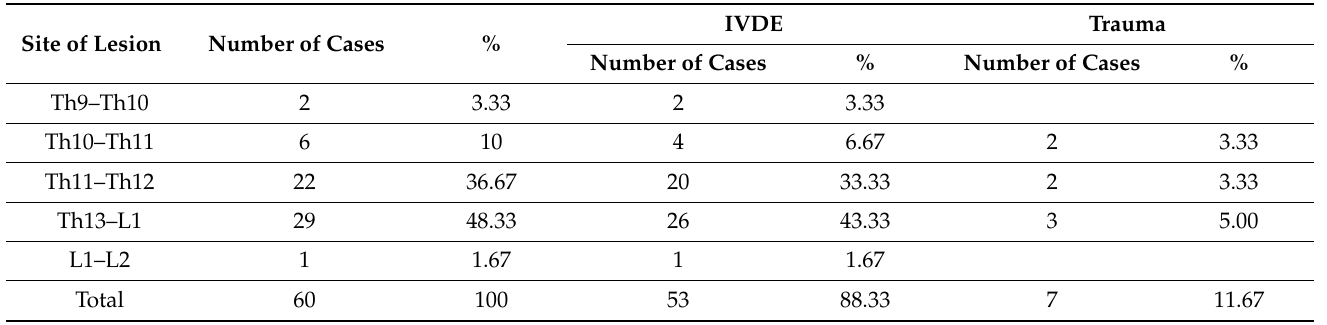
Table 1. Sites and types of lesions (60